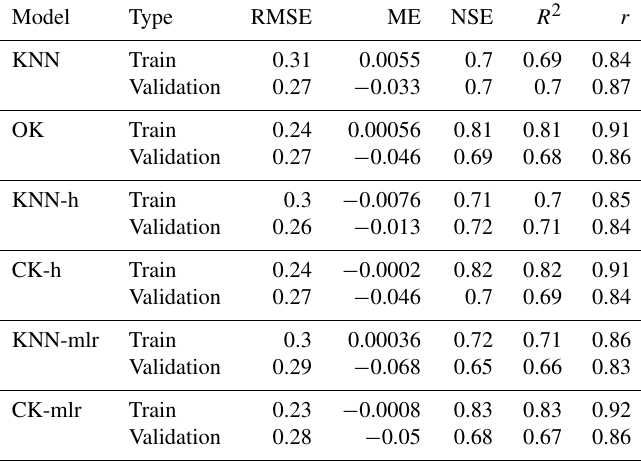
Table 3. Performance measures of the different tested interpolation methods (see text for further